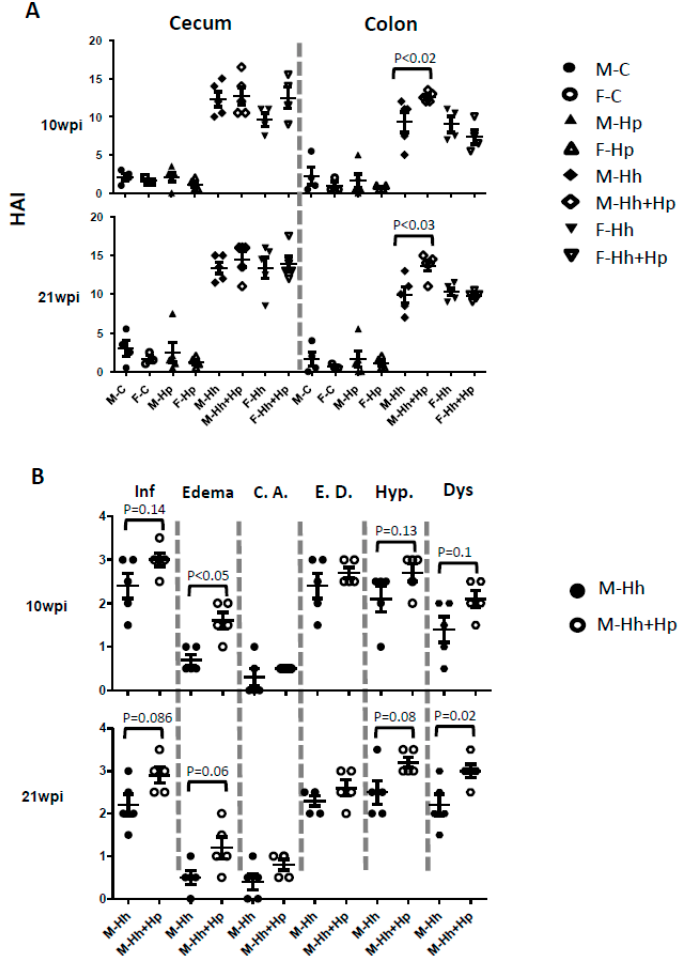
Figure 3. Co-infection with Hp promoted Hh-induced colonic lesions compared with mono- Hh in a male-dependent manner. Cecum and colon from RAG mice infected with Hh, Hp or co-infected with Hh+Hp for 10 to 21 weeks (WPI) ( n = 3–5 per group) were graded for inflammation (Inf), edema, crypt atrophy (C.A.), epithelial defects (E.D.), hyperplasia (Hyp.) and dysplasia (Dys.). ( A ) Intestinal histologic activity index (HAI) was generated by combining scores for all sub-categorical lesions. ( B ) Scores of sub-categorical lesions of colon in male mice.